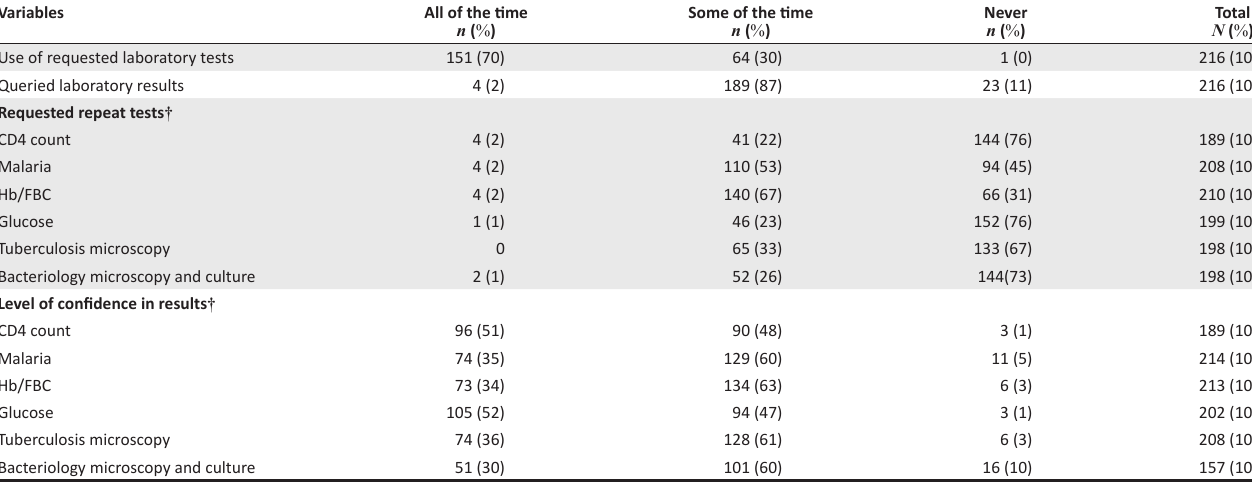
TABLE 2: Ordering and use of laboratory results by clinicians in Malawi, October–November 2012.